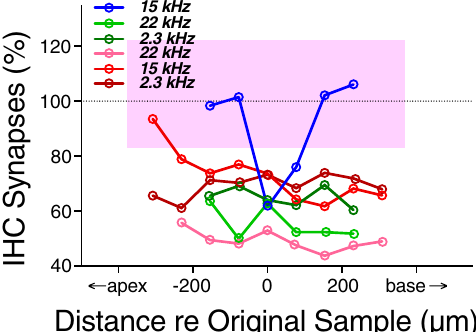
Figure 8. Most synaptopathic regions spanned at least 500 microns (~60 IHCs) along the cochlear spiral. For several of the synaptopathic points identified in the routine screen of half-octave positions along the cochlear spiral (e.g. Fig. 5B), we went back to the samples and imaged adjacent fields apical and basal to the initial sample. The case-identifying colors used here are the same as those in Fig. 5B; the key identifies the frequency region in question. The shaded pink region represents the combined control range from 2.3, 15, and 22 kHz.